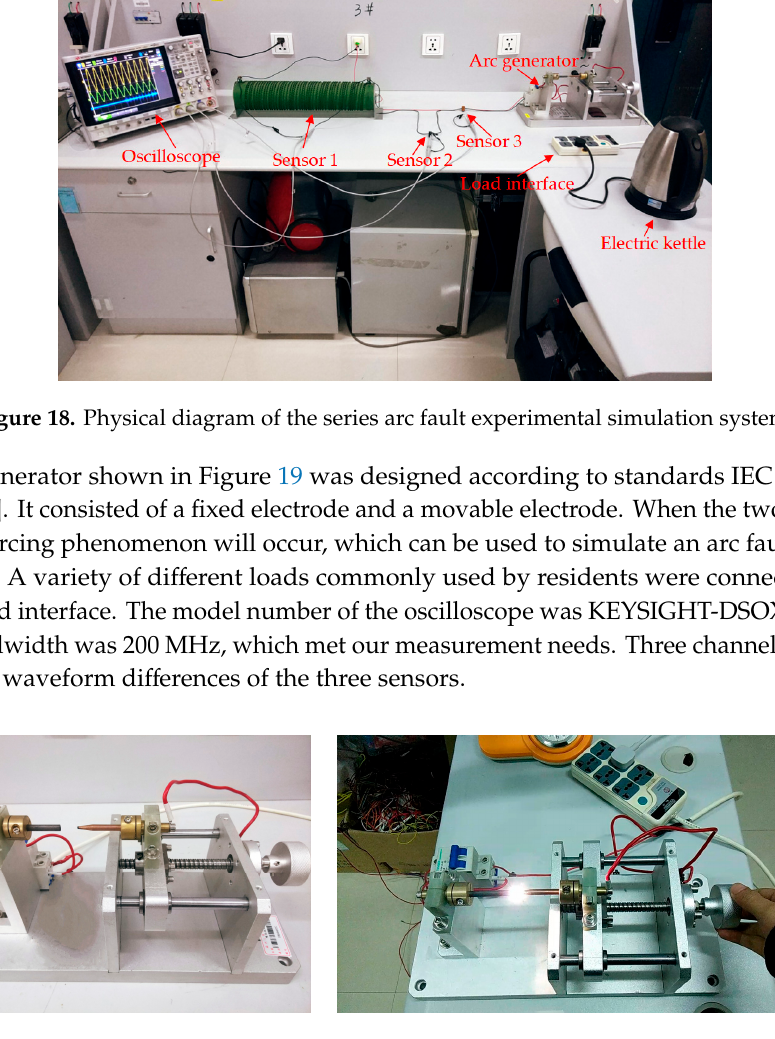
Figure 17. Schematic diagram of the series arc fault experimental simulation system.